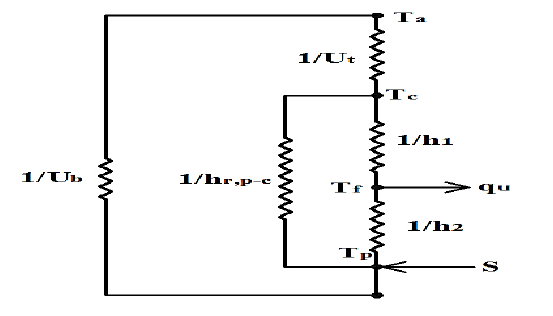
Fig. 4. Thermal network for the collector of solar